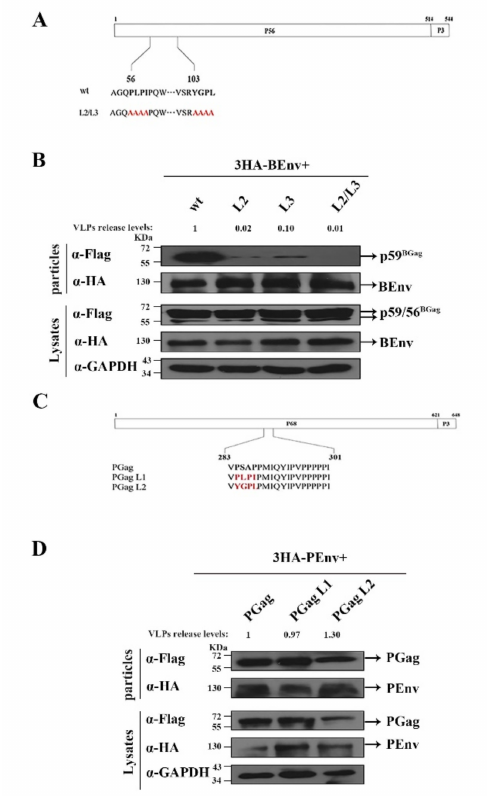
Figure 3. PLPI and YGPL are the two L domains in BGag. ( A ) Schematic organization of the BFV Gag protein (BGag) precursor protein and processing products p56 and p3. Below, the sequences of the indicated specific regions of wild-type and mutant BGag protein are shown. The two L domain sequence motifs are highlighted in bold, and amino acids altered in the mutant constructs are marked by red letters. ( B ) Representative Western blotting analysis of HEK293T cell lysates (Lysates) and virus-like particles (VLPs) purified by ultracentrifugation through 20% sucrose using monoclonal anti-Flag ( α -BGag) and anti-HA ( α -BEnv)-specific antisera. To quantify the levels of released VLPs, the amount of BGag in VLPs was normalized against the amount of intracellular BGag, which were first normalized against the GAPDH loading control. ( C ) Replacement of PFV L domain motif with BFV L domain motifs. Schematic organization of the PFV Gag protein (PGag). The PGag L domain sequence motif is highlighted in bold, and amino acids altered in the mutant constructs are marked by red letters. ( D ) HEK293T (4 × 10 6 ) cells were transfected with 3HA-PEnv and either the wild-type or domain-mutated PGag vector constructs and harvested at day 2 post-transfection. The cell culture supernatants were filtered through a 0.45 µ m filter and purified by ultracentrifugation. Transfected cells were disrupted using lysis buffer. Levels of Gag and Env in the supernatant and cell lysate were measured using Western blotting. To quantify the levels of released VLPs, the amount of PGag in VLPs was normalized against the amount of intracellular PGag, which were first normalized against the GAPDH loading